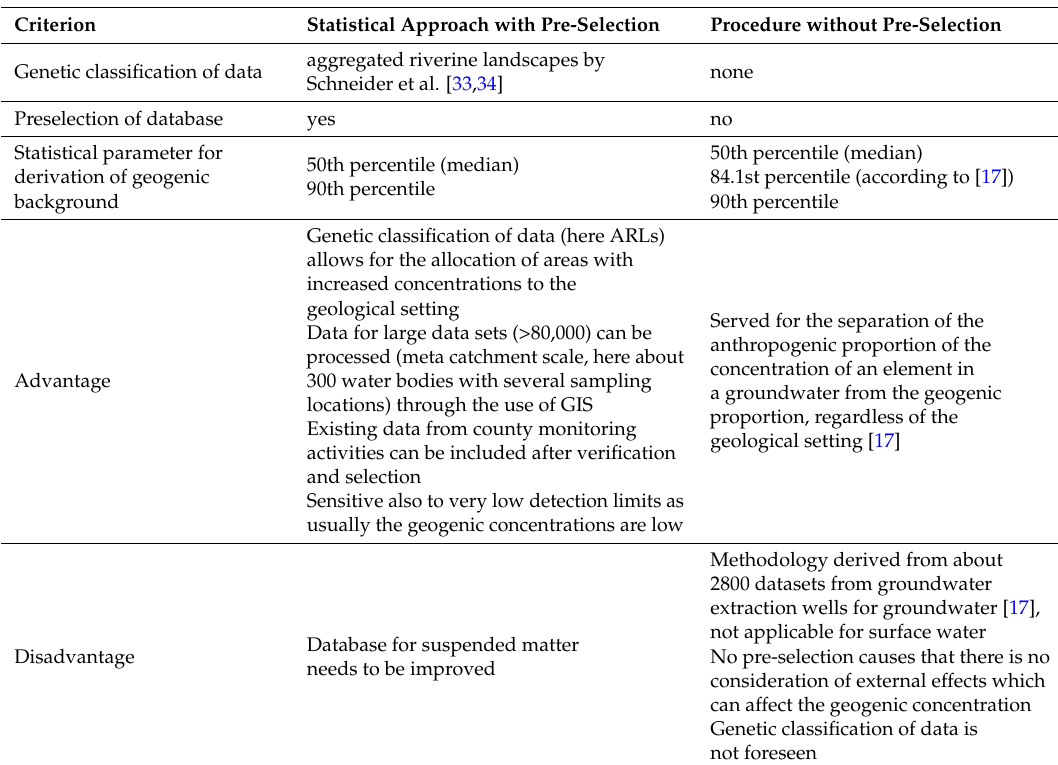
Table 1. Specific criteria for the geogenic